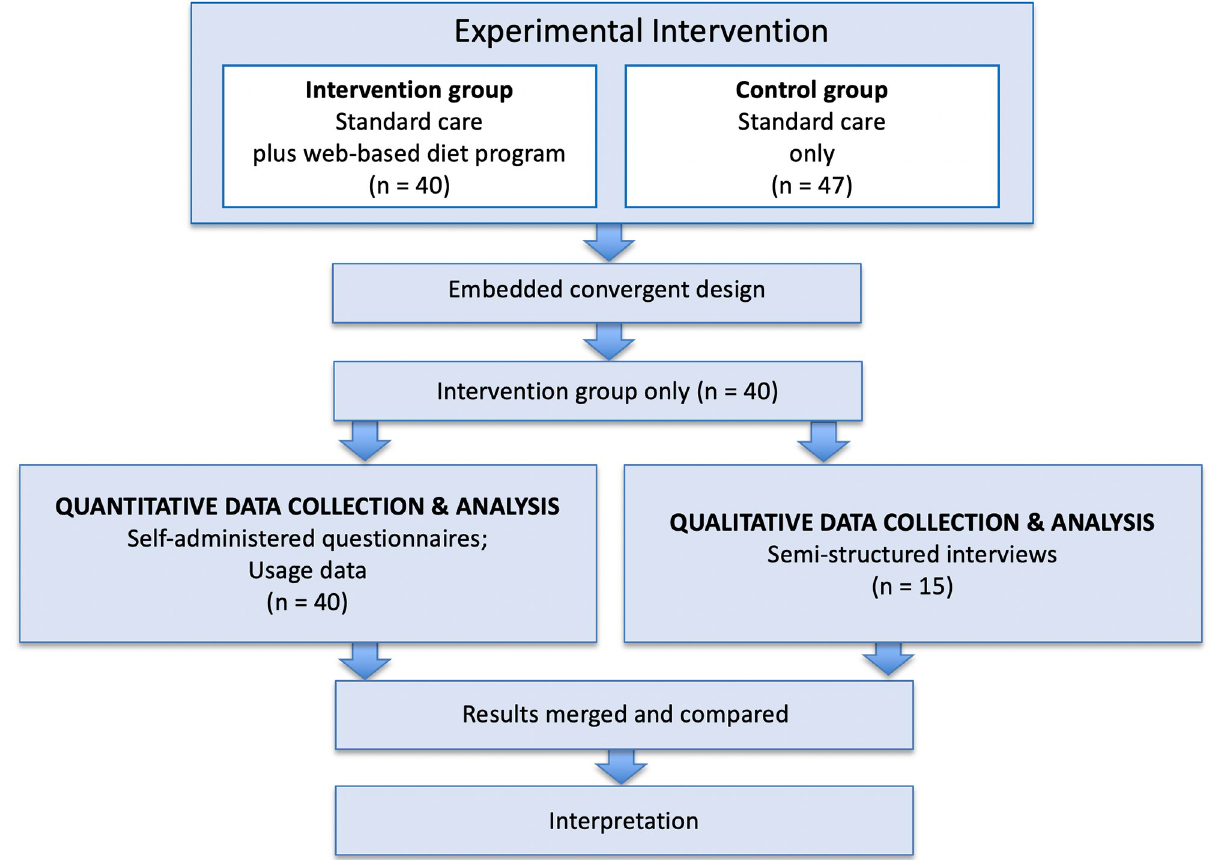
Fig 1. Overview of the mixed methods intervention design, with embedded convergent